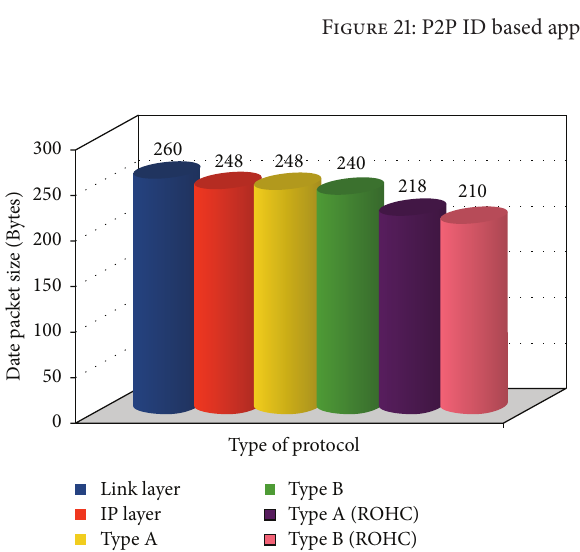
Figure 22: Frame size of RTP/UDP/IP packet under different pro- tocols.